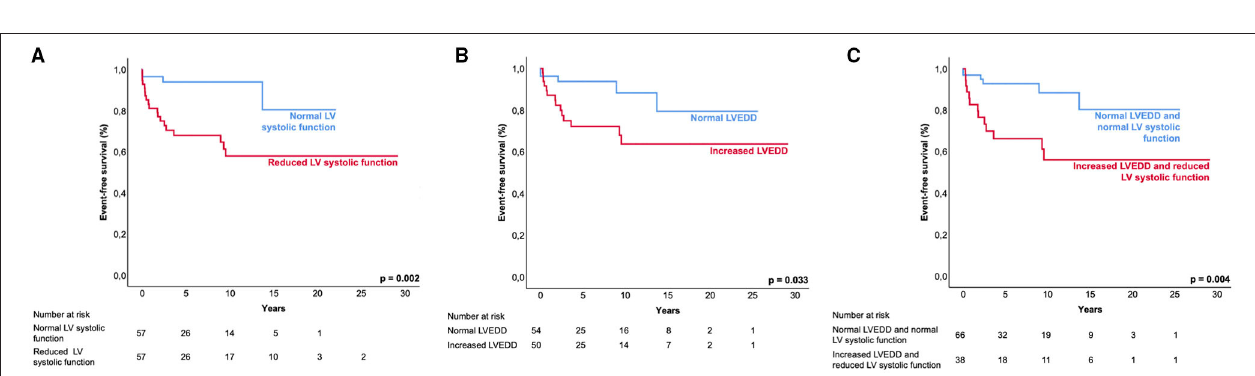
FIGURE 3 | Follow up in LVNC patients. Patients were sorted into subgroups according to their phenotype at first presentation. (A) , normal LV systolic function and reduced LV systolic function. (B) , normal LVEDD and increased LVEDD and (C) , ’normal LVEDD and normal LV systolic function’ and ‘increased LVEDD and reduced LV systolic function’. At the last available follow-up, the respective phenotypes were recorded. In some of the patients, heart transplantation (HTx) or death had occurred. LV, left ventricular; LVEDD, Left ventricular end-diastolic diameter.